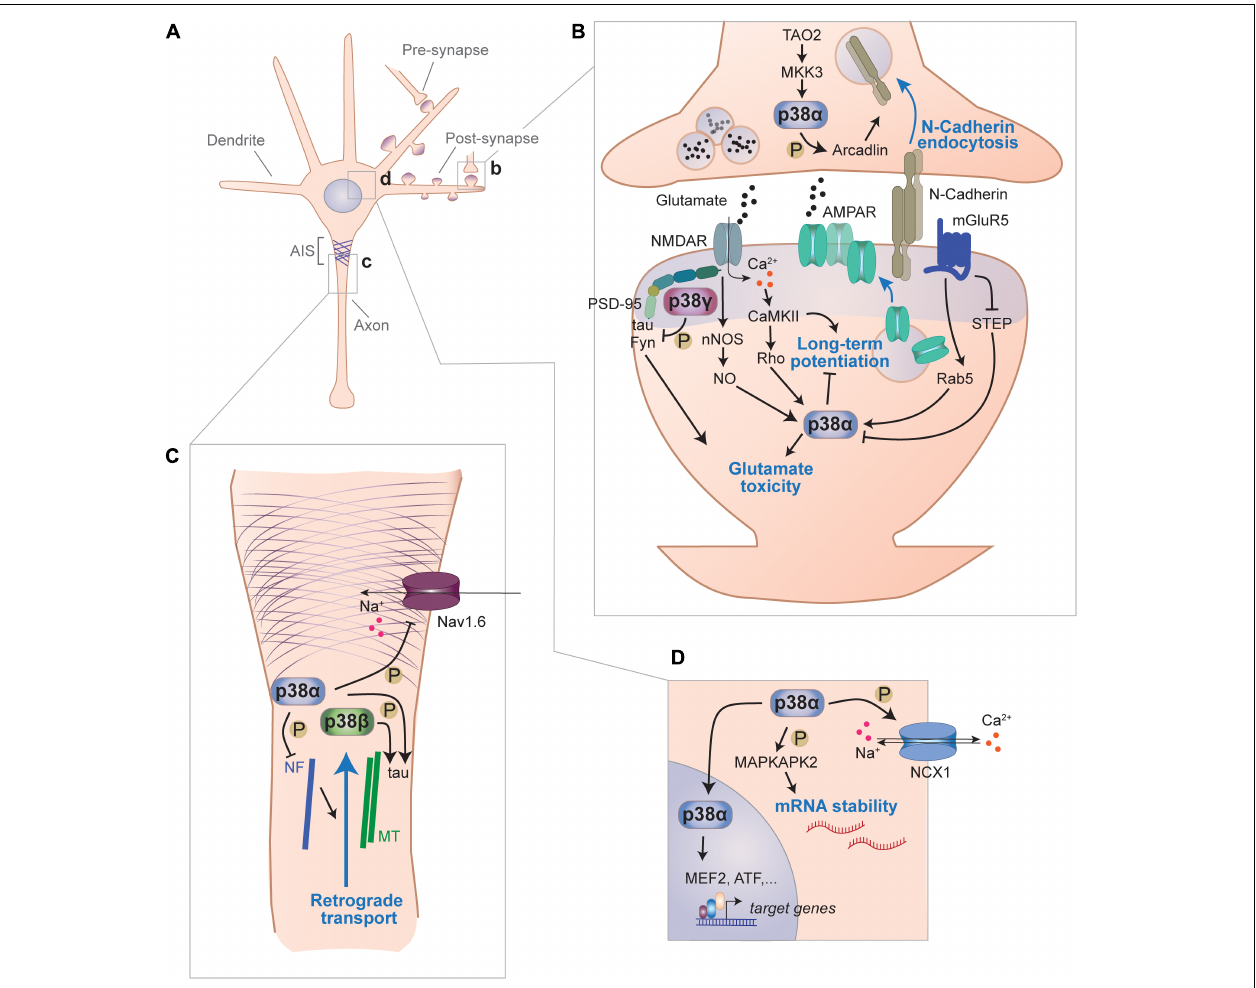
FIGURE 2 | Signaling functions of p38 kinases in neurons. (A) Functions of p38 kinases in neurons have been described for different subcellular locales, including pre- and postsynapse, axon and cell body. (B) p38 kinases are involved in signal transduction at synapses. Within the pre-synaptic moiety of synapses, p38 α phosphorylates arcadlin to promote N-Cadherin endocytosis from the active zone when activated downstream of TAO2 and MKK3. p38 α is engaged downstream of multiple post-synaptic pathways and impairs LTP, which involves increasing surface expression of AMPA-type glutamate receptors (AMPAR) and promotes toxicity from excess glutamate. In this context, p38 α is activated downstream of NMDA receptors through neuronal nitric oxide synthase (nNOS)-mediate nitric oxide (NO) production or through CaMKII) activity. Alternatively, p38 α is activated downstream of metabotropic glutamate receptor 5 (mGluR5) through small G-protein Rab5 and/or inhibition of striatal enriched phosphatase (STEP). p38 γ , which binds to PSD-95 within the post-synaptic density, phosphorylates tau and inhibits glutamate excitotoxicity mediated by tau and Fyn kinase. (C) p38 kinases are involved in axonal signaling. p38 α phosphorylate voltage-gated sodium Nav1.6 channels, which localize to the axon initial segment, and reduce their sodium currents. p38 α phosphorylates neurofilaments and thereby impair retrograde axonal transport processes. Both, p38 α and p38 β were shown to phosphorylate the cytoskeletal protein tau that associates with axonal microtubules (MT). (D) p38 kinases regulate neuronal processes with the soma and nucleus. p38 α regulates sodium/calcium exchange channel NCX1 by phosphorylation. p38 α targets MAP kinase-activated protein kinase-2 (MK2) that promotes stability of AUC-rich element containing neuronal messenger RNAs. Furthermore, p38 α regulates gene expression through nuclear targets such as MEF2 or ATF transcription